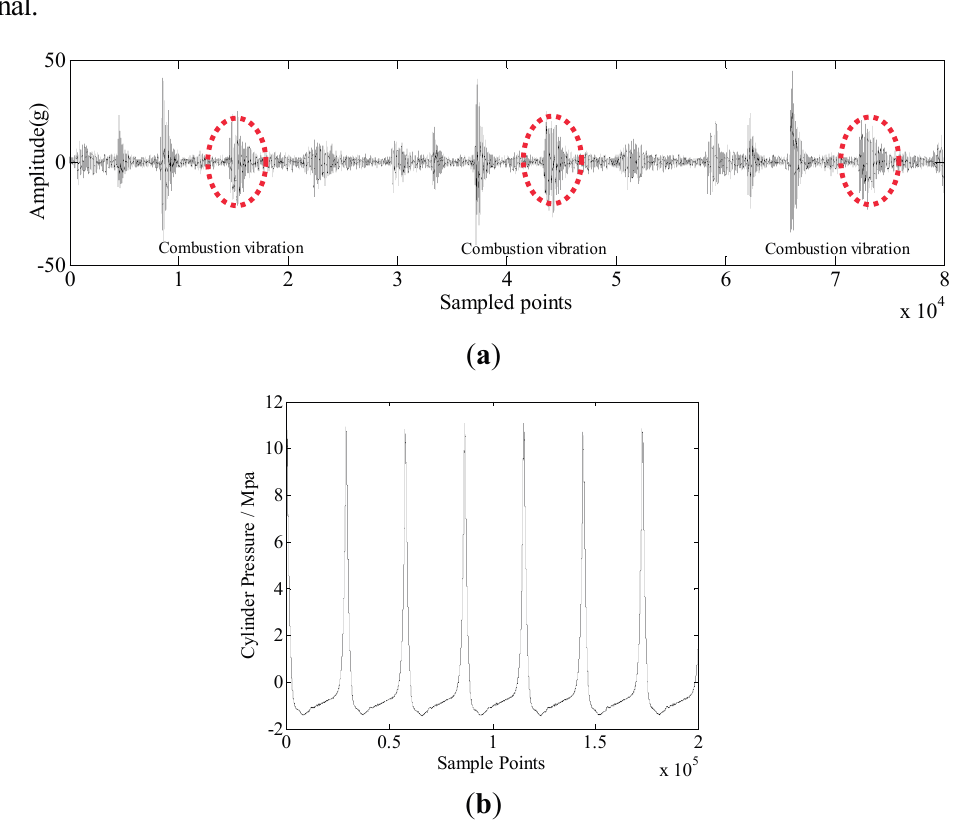
Figure 8. ( a ) Sampled cylinder vibration signal; ( b ) Sampled cylinder pressure